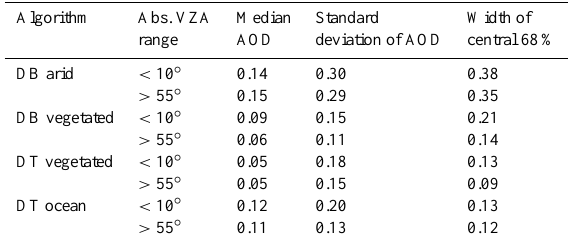
Table 1. Median, standard deviation, and width of central 68% of AOD at 550nm for the histograms shown in Fig.